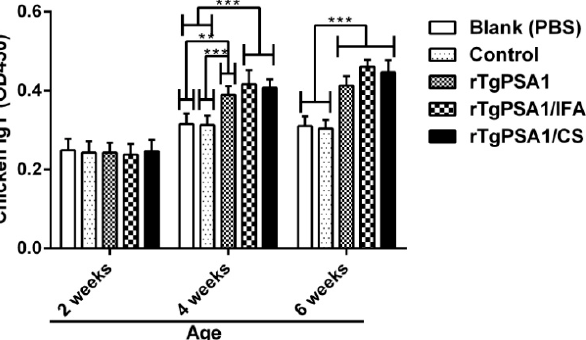
Figure 8. Total IgY antibody calculation in sera of chickens immunized at two, four, and six weeks of age. Each sample was conducted once. Values were assessed using one-way ANOVA followed by Dunnett’s test, and are shown as means of OD450 ± SD (n = 5). Values between rTgPSA1/IFA and rTgPSA1/CS groups were compared with the independent t -test. ** p < 0.01 and *** p < 0.001 compared with blank or control group.